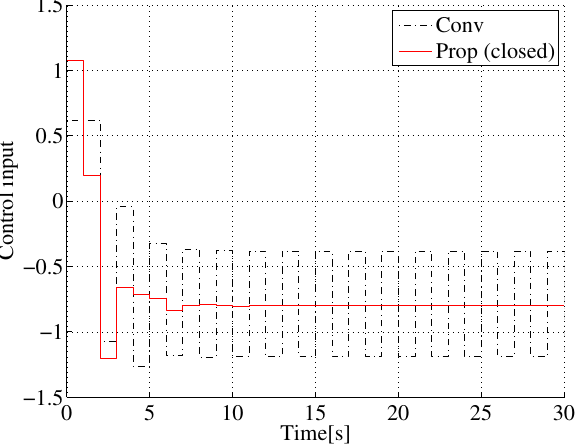
Figure 10. Input trajectories for unstable